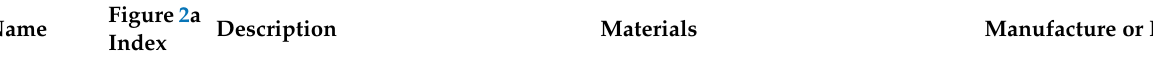
Table 1. Components of the mini-Secchi